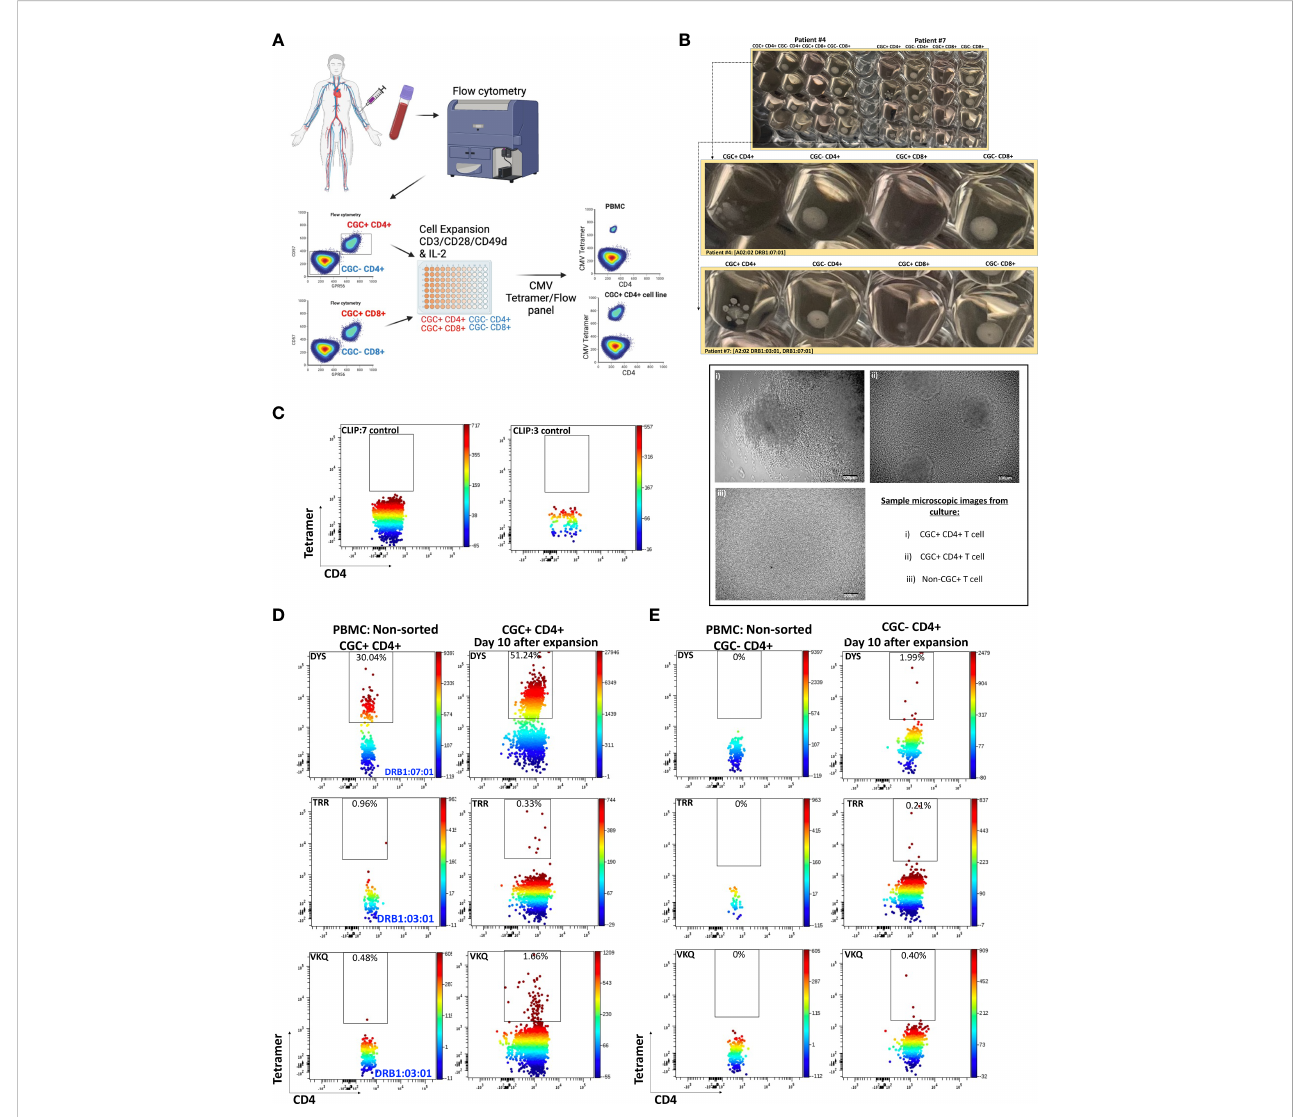
FIGURE 5 CMV-speci fi c T cells among expanded CGC + CD4 + and non-CGC + CD4 + T cells. Schematic showing work fl ow for sorting and expansion of CGC + and non-CGC + cells (A) . Cell expansion cultures from two participants (Supplemental Table 2, participants #4 & #7) on day 10 of expansion. The top fi gure shows duplicate wells, with the middle panel showing an enlarged image to highlight the satellite cultures in CGC + CD4 + T cells by direct observation and by light microscopy (B) . Tetramer staining controls on expanded cells (DRB1:07:01) and DRB1:03:01) with CLIP peptide (C) . Two-dimensional fl ow cytometry plots showing CMV-speci fi c T cells using tetramers against three different CMV MHC class II epitopes (DR7:DYS) and (DR3:TRR, DR3:VKQ) in non-sorted PBMCs and expanded CGC + CD4 + T cells (D) . Similar analysis on non-CGC + CD4 + T cells gated from PBMCs and on expanded non-CGC + CD4+ T cell line (E)